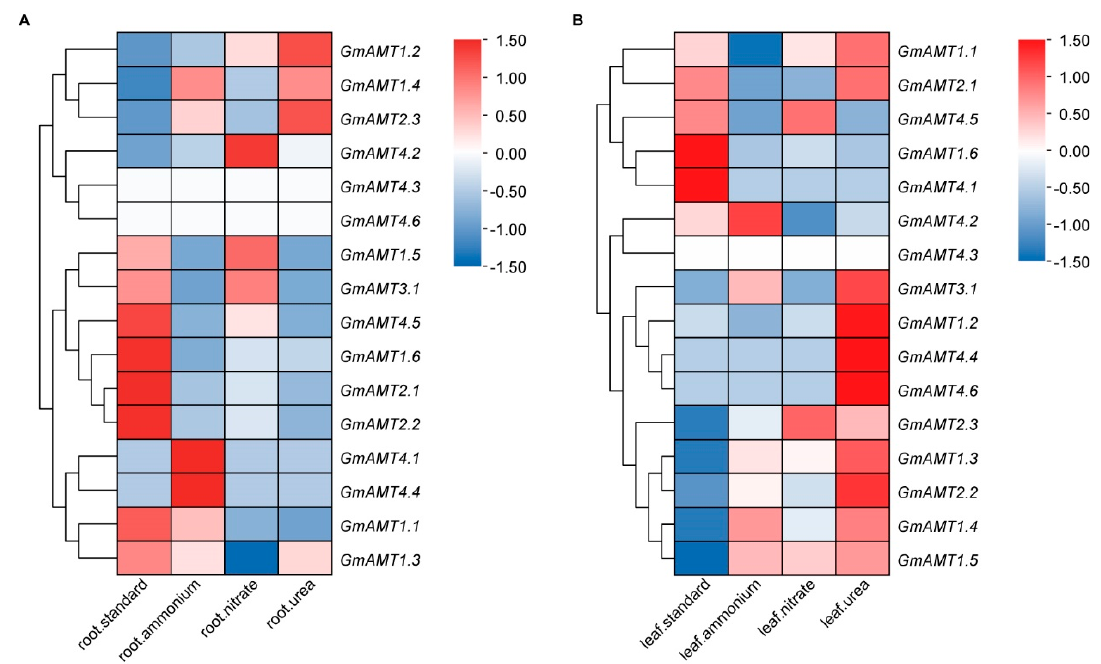
Figure 8. Expression patterns of GmAMTs in response to different forms of nitrogen treatment based on RNA-seq data. The GmAMT data were collected from the JGI Plant Gene Atlas [45] and shown by heatmaps with clustering created based on the normalized FPKM values of GmAMT genes in roots ( A ) and leaves ( B ). The white color represents NA (not available).